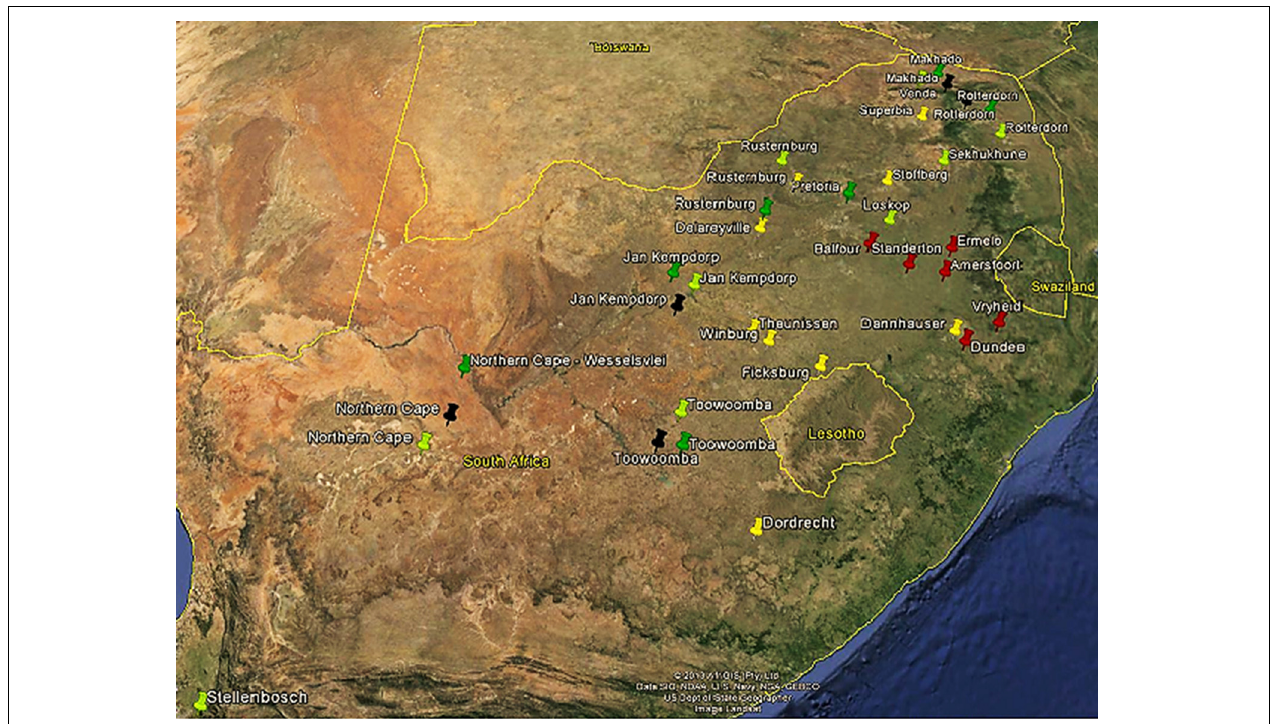
FIGURE 1 | Geographic origin of five cattle breeds in South Africa sampled in the current study. Afrikaner (yellow) (44), Nguni (light green) (56), Drakensbureger (red) (47), Bonsmara (dark green), and Angus (black) (31).